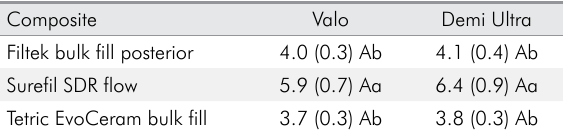
Table 3. Means (±SD) of the roughness profile (Rv in µm).